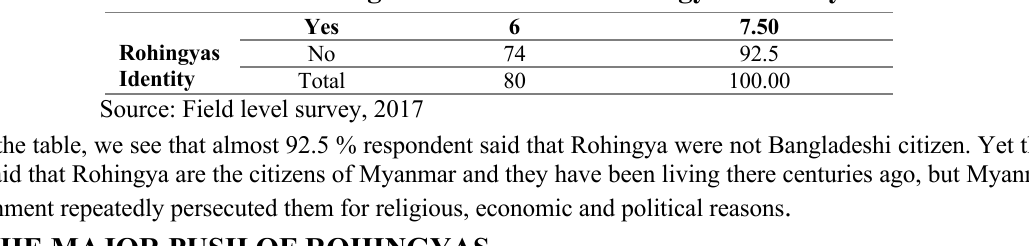
Table1: Percentage Distribution of Rohingyas Identity